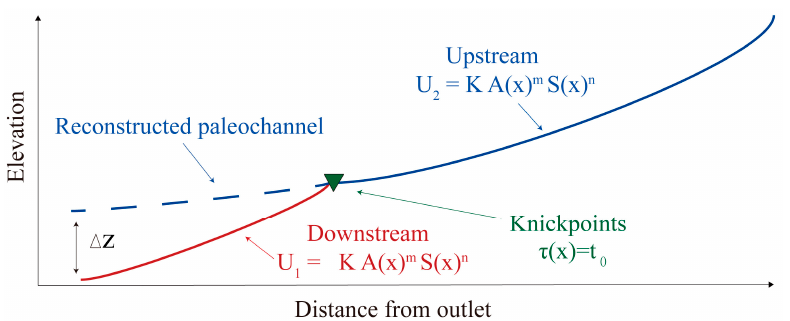
Figure 3. Schematic diagram of the paleochannel reconstruction, modified from [34].